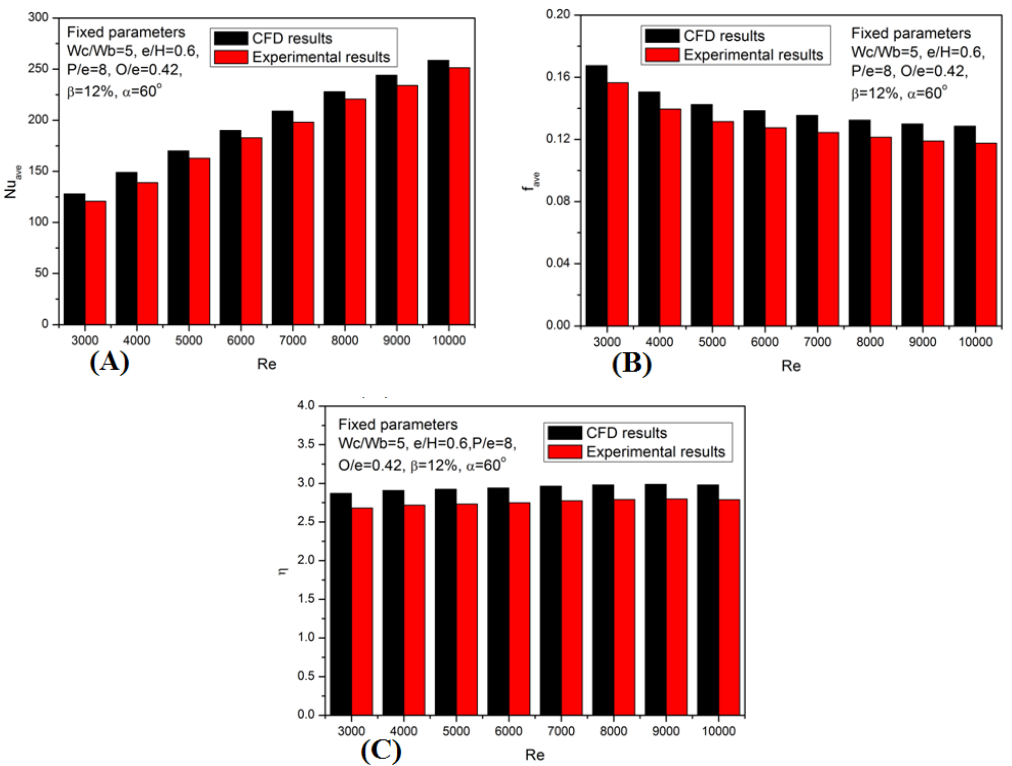
Figure 12. Comparison of CFD results with experimental results: ( A ) Nusselt number; ( B ) friction factor; and ( C ) thermal-hydraulic performance.